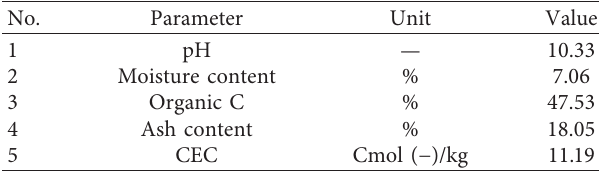
Table 2: Chemical properties of bamboo